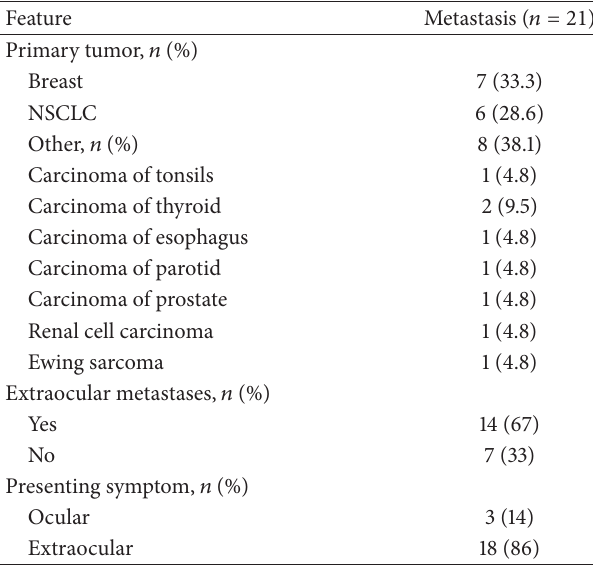
Table 2: Oncologic features of choroidal metastases in 21 eyes of 21 patients.